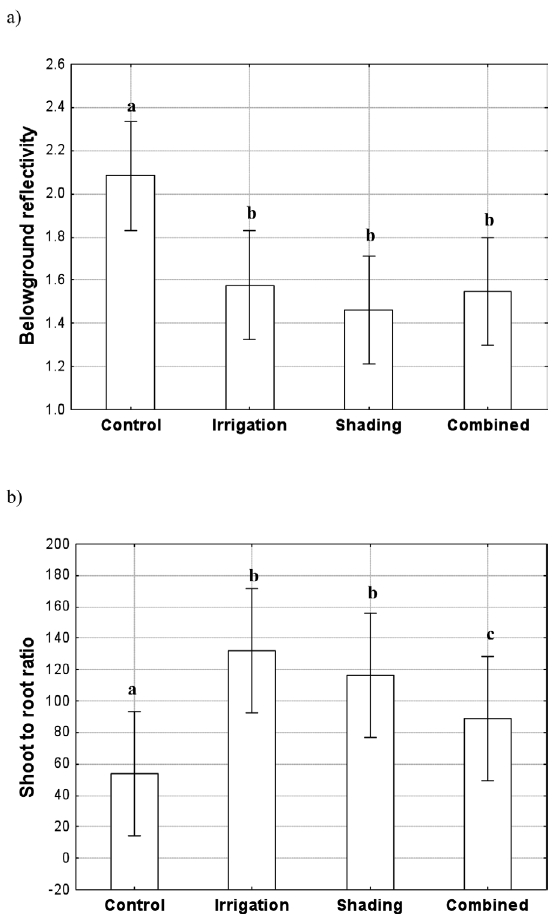
Fig. 3. Ground reflectivity (a) and shoot-to-root ratio (b) in plots of planted Q. ilex trees after 13 years having previously been treat- ed by a combination of summer irrigation and artificial shading for the first three years. Different letters above the bars indicate statistical differences at p = 0.05 according to a Tukey´s test. Bars denote 95% confidence